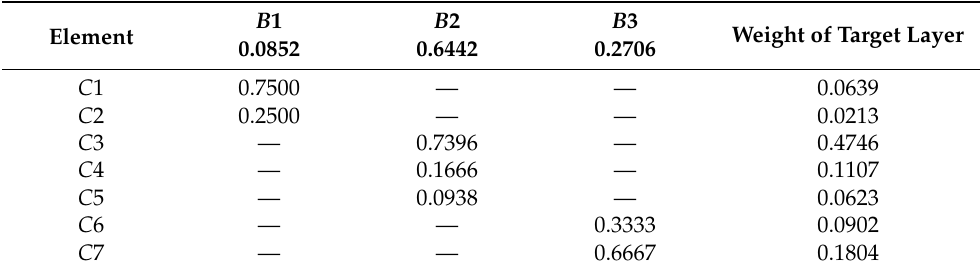
Table 2. The weight of each layer’s elements in relation to the target layer.